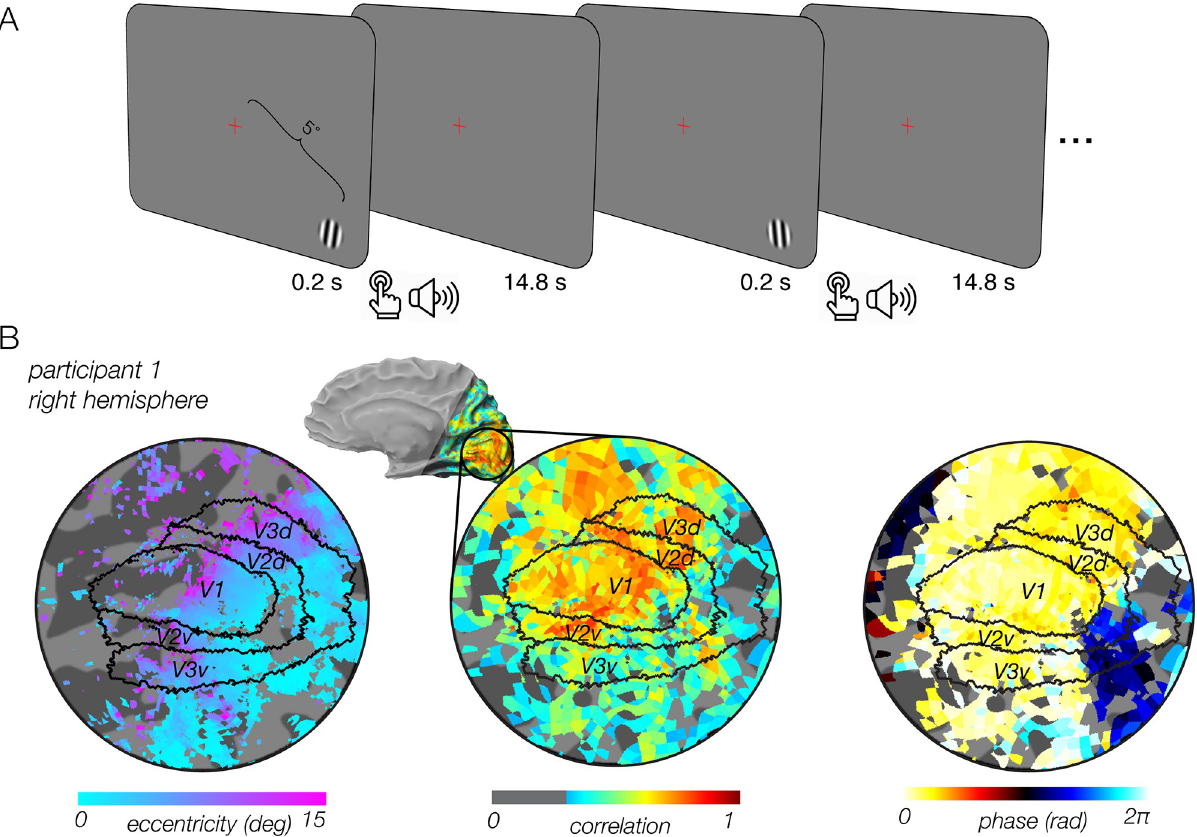
Fig 1. Experiment design and task-related fMRI activity in early visual cortex. (A) Experiment design. Participants were instructed to continuously fixate on a central cross while performing a 2AFC orientation discrimination task on a peripheral stimulus. On each trial, a small grating was briefly presented for 200 ms in the bottom right of the screen. Participants indicated whether it was tilted CW or CCW relative to vertical and received immediate auditory feedback. Participants maintained fixation until the next trial. In each run, participants could gain either a high or low monetary reward for correct performance. (B) Medial view (inset), and a flattened map of ipsilateral visual cortex (bottom panels) of participant P1. Left: visual eccentricity. Hue indicates eccentricity of the population receptive field center for each voxel. Retinotopic borders of V1–V3 were defined by an anatomical template extending to 80˚ eccentricity, well beyond the spatial extent of the screen. Map threshold, r 2 > 0.1. Shaded region on medial views indicates cortex not included in the imaged field of view. Center: response correlation, showing a widespread fMRI response linked to task timing. Map threshold, r > 0.3. Hue indicates correlation with best-fitting cosine at the task frequency. Right: response phase. Same threshold as middle panel, with hue indicating phase of best-fitting cosine for each voxel. Phase values indicate the response latency for each voxel. Underlying data can be found at https://osf.io/cbjq6/. 2AFC, two-alternative forced choice; CCW, counterclockwise; CW, clockwise; fMRI, functional MRI.